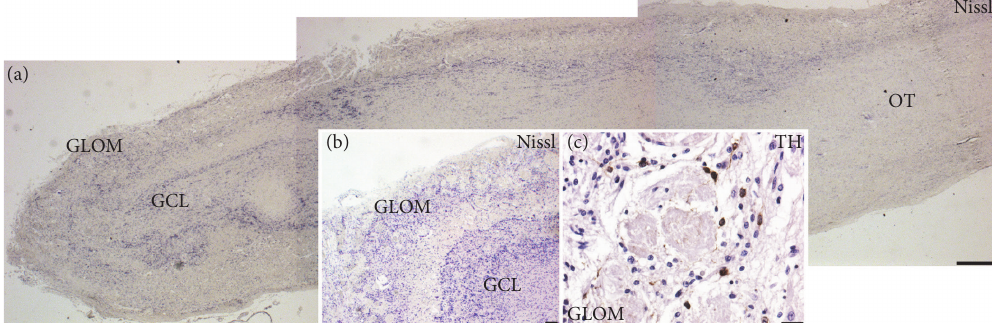
Figure 1: Overview of the human olfactory bulb (OB) analyzed in the study: (a) Nissl staining of the human olfactory bulb showing the glomerular layer (GLOM), the granular cell layer (GCL), and the olfactory tract (OT). Inserts: (b) higher magnification of the most rostral portion of an OB depicting the distribution of Nissl stained cells in the GLOM and the GCL. (c) The GLOM was further identified by staining for tyrosine hydroxylase (TH) expressing neurons within glomeruli, counterstained with hematoxylin. OB tissue from control case, scale bars represent 500 𝜇 m in (a) and 50 𝜇 m in inserts (b,